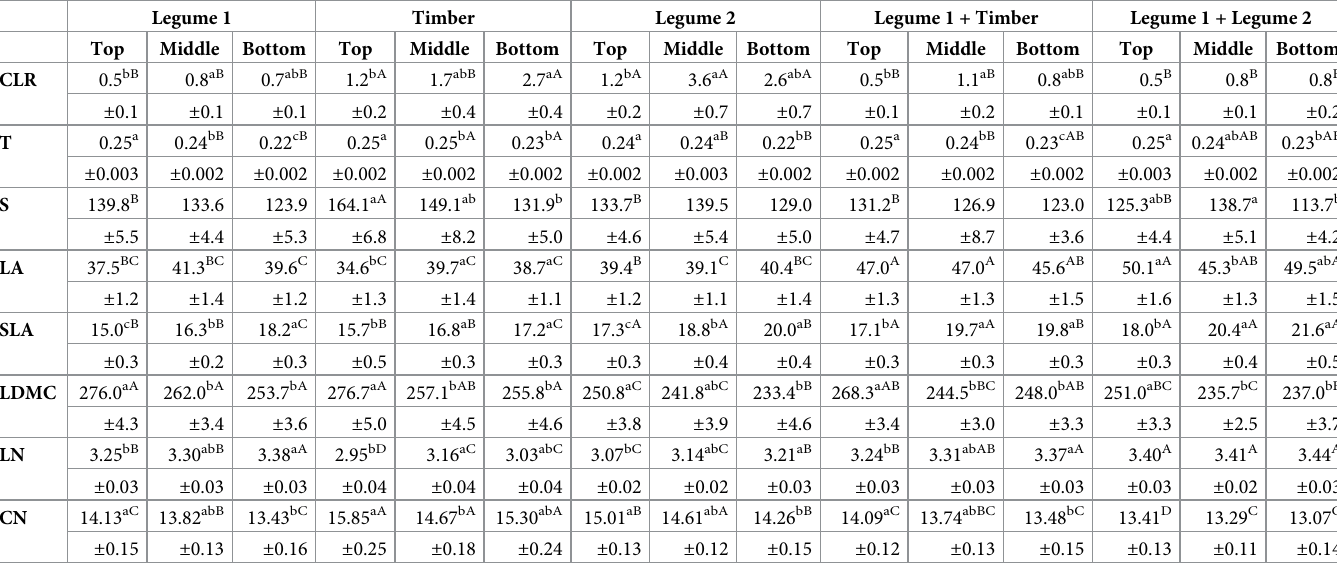
Table 1. Means and standard errors of CLR severity and coffee leaf traits across shade tree treatments and coffee plant strata. Legume 1 Timber Legume 2 Legume 1 + Timber Legume 1 + Legume 2 Top Middle Bottom Top Middle